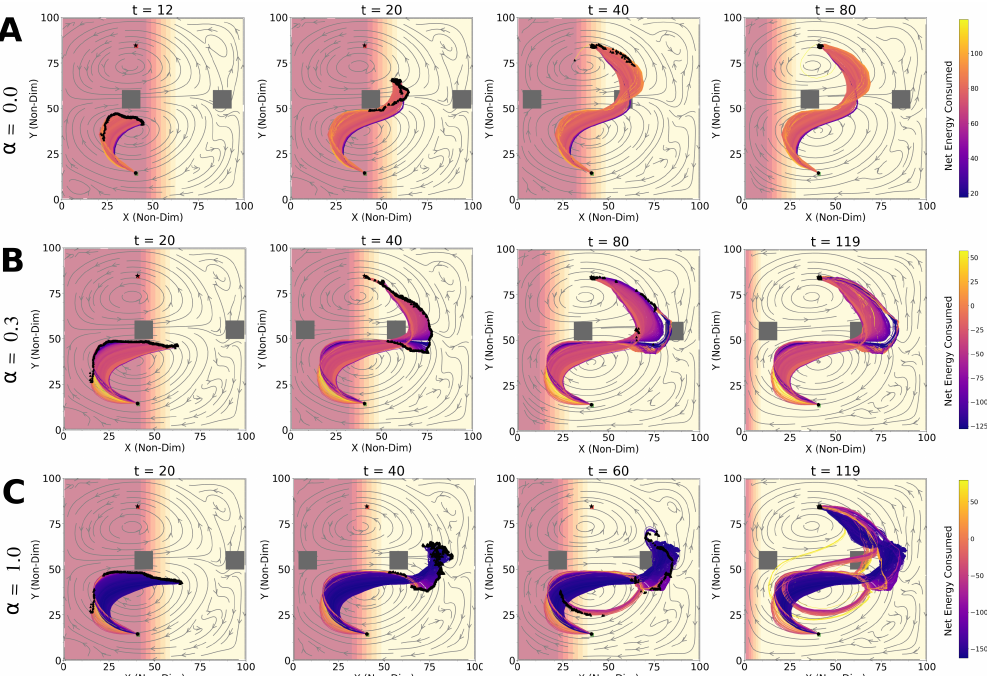
Figure 3. Time evolution of trajectory distribution obtained by following the optimal policy for different α values for optimal time and net energy mission. ( A ) α = 0, equivalent to time optimal planning; ( B ) α = 0.3, intermediate behavior between α = 0 and α = 1; ( C ) α = 1, equivalent to net-energy optimal planning. The background is colored with the solar radiation’s magnitude and overlaid with flow streamlines. Trajectories are colored with their net-energy consumption. Note that the time stamp of individual snapshots are different.